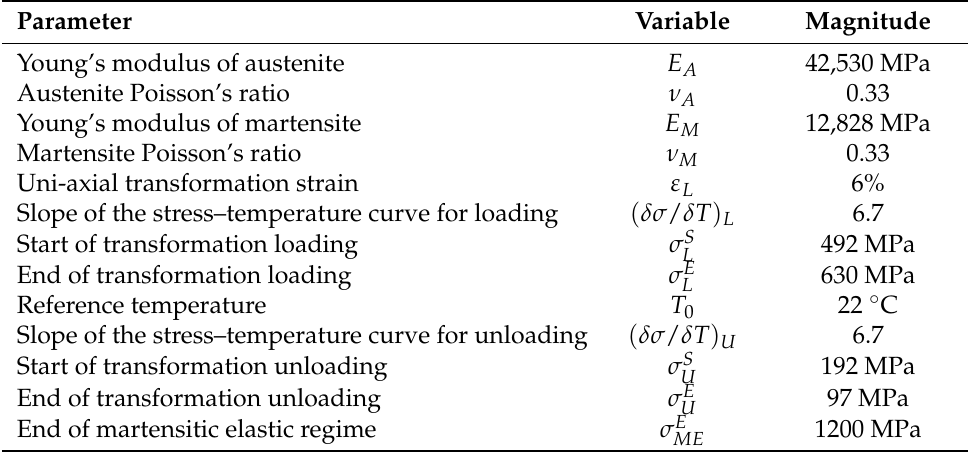
Material properties to characterize the super-elastic behavior of NiTi alloy. Reprinted/adapted with permission from Ref. [10]. 2014,